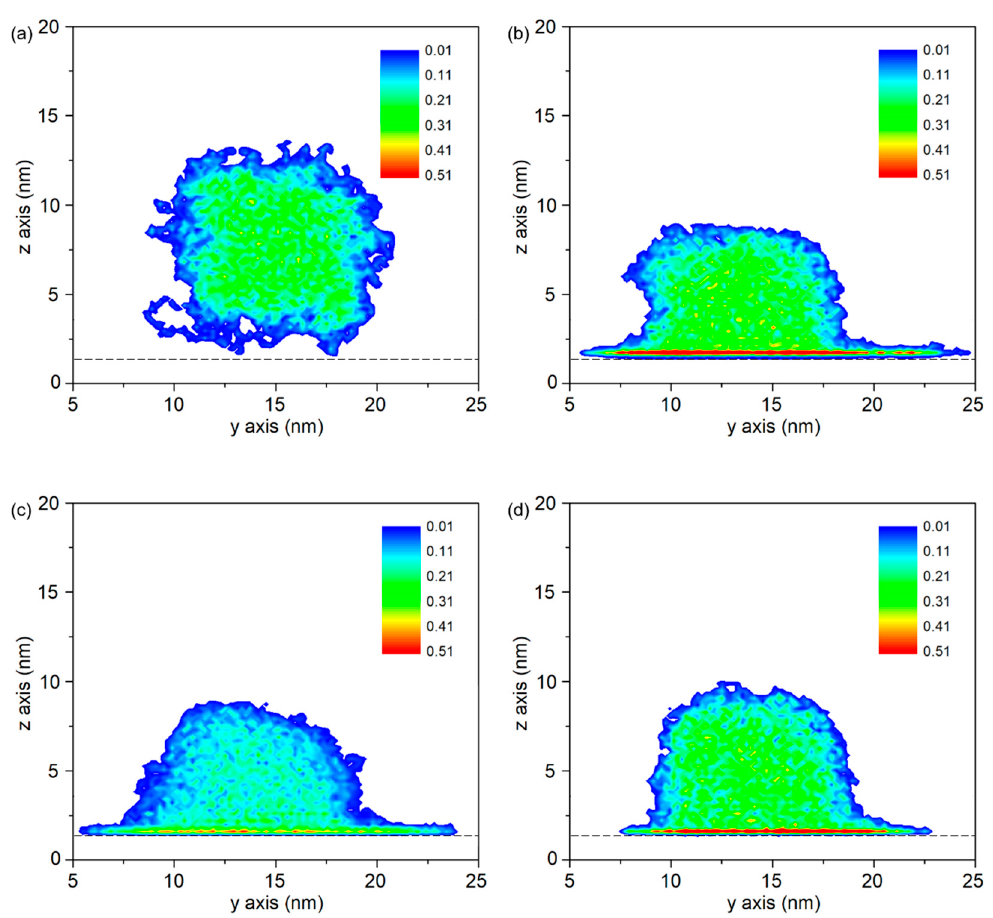
Figure 7. Density distributions of the PP droplet on different substrate. ( a ) initial density of PP droplet on Al substrate, final density distributions of PP droplet on ( b ) Al substrate, ( c ) Ni substrate and ( d ) Fe substrate at the simulation time of 6.5 ns.